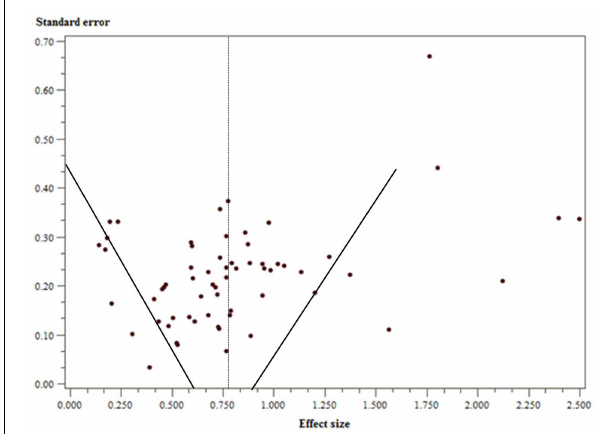
FIGURE 2 | Funnel plot of effect sizes from included